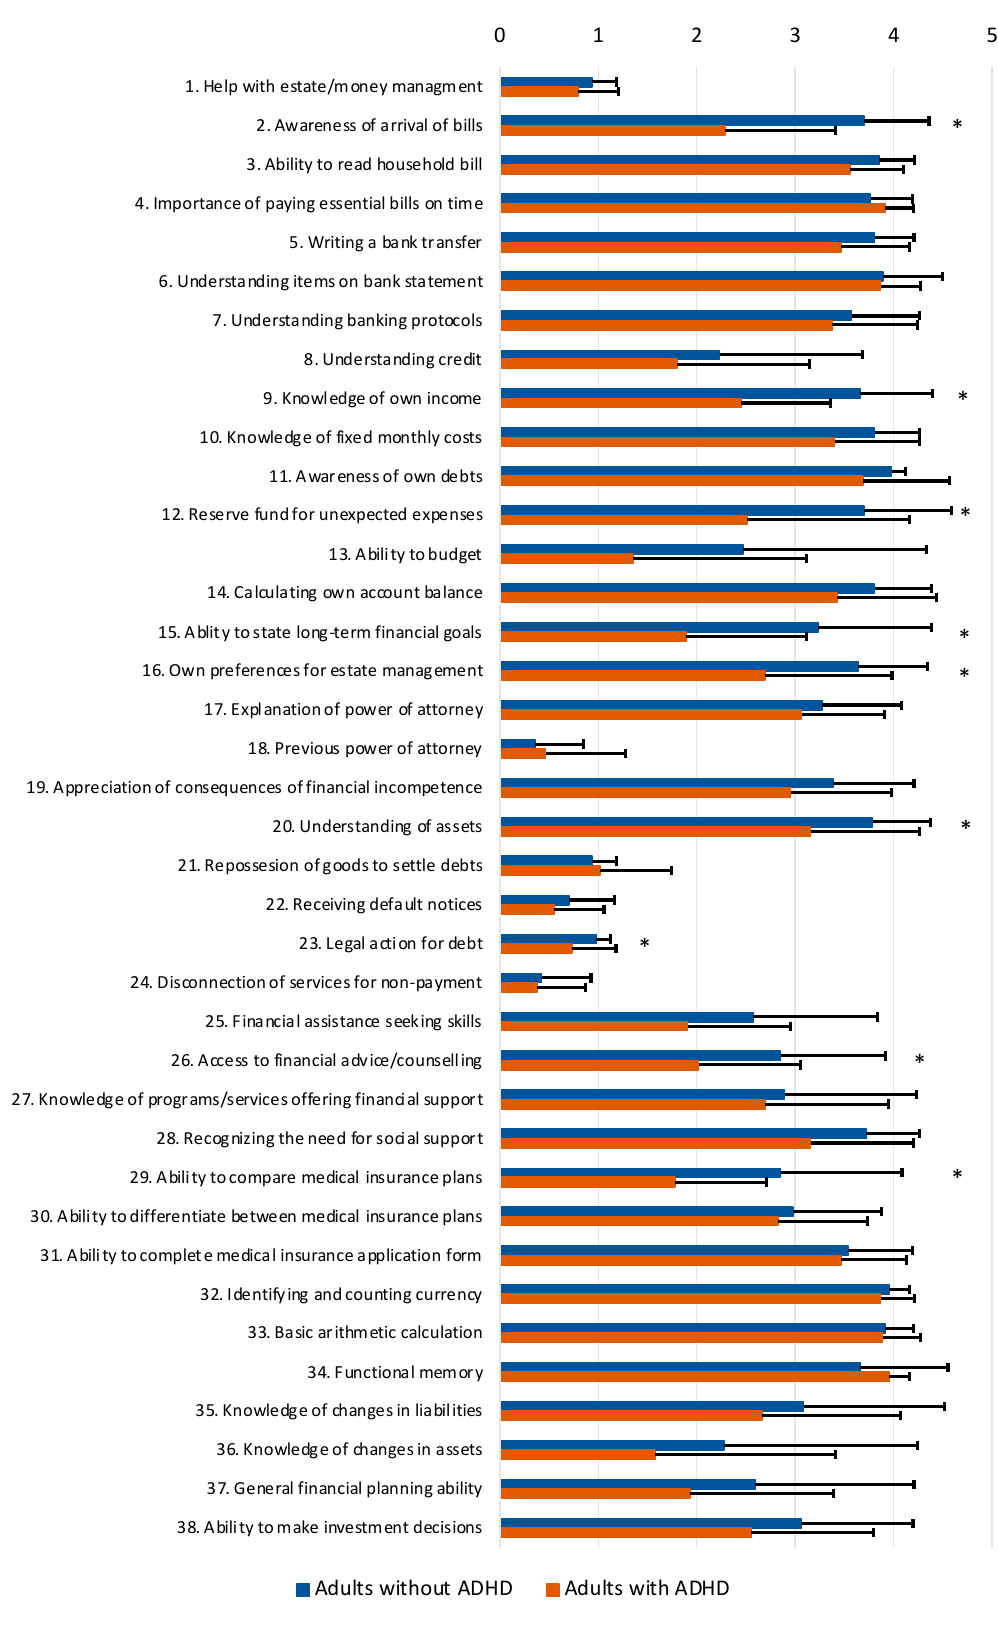
Figure 1. Comparison of performance on FCAI items (M and SD) of adults with ( n = 45) and without ADHD ( n = 47). Note: * p <